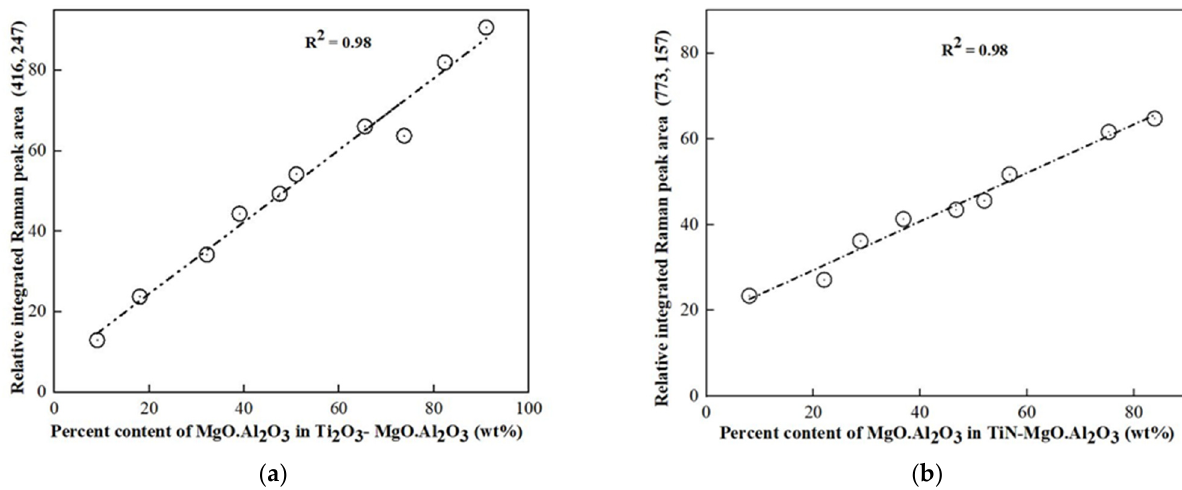
Figure 4. Estimation of phase contents based on relative integrated Raman peak area as a function of the phase content of MA in ( a ) Ti 2 O 3 –MgO·Al 2 O 3 and ( b ) TiN–MgO·Al 2 O 3 .